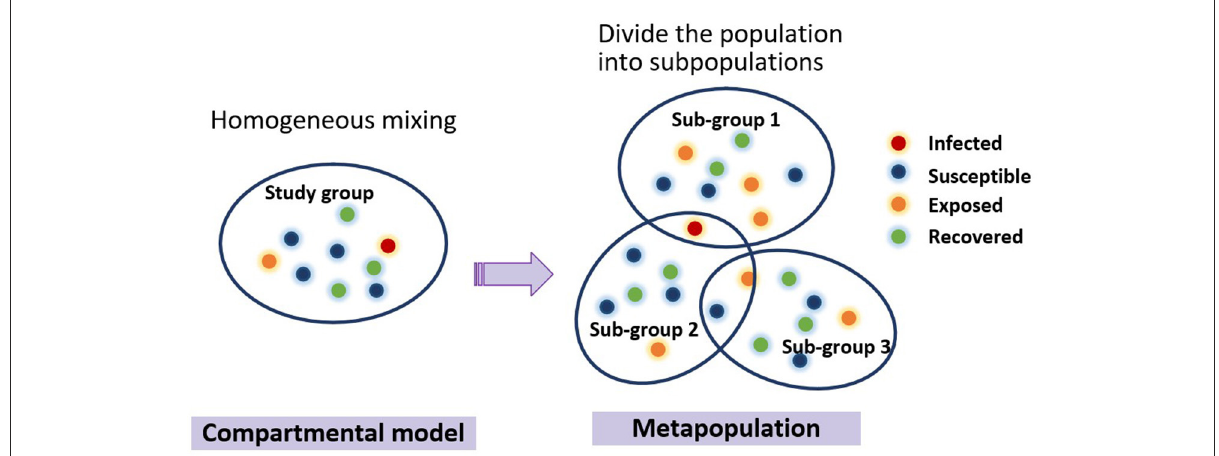
FIGURE2 Evolution of the typical macro-dynamic models. Each circle represents an individual, and different color of the circle signifies different type of people. Compartmental model treats the population as homogeneous mixing, while metapopulation model divides the population into several subgroups. People can come and go between populations, and the compartmental model can be used to simulate the internal transmission process of infectious diseases within populations.